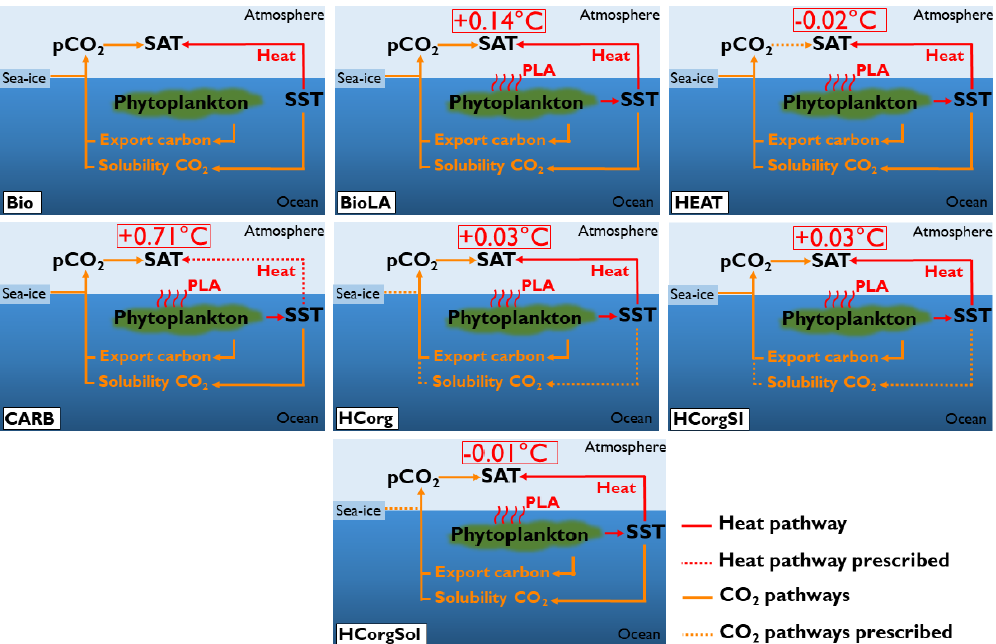
Figure 7. Sketch representing the surface atmospheric temperature (SAT) changes between the simulations and the reference run. On top is located the value of SAT change compared to Bio. The rest of the sketch is similar to Fig.